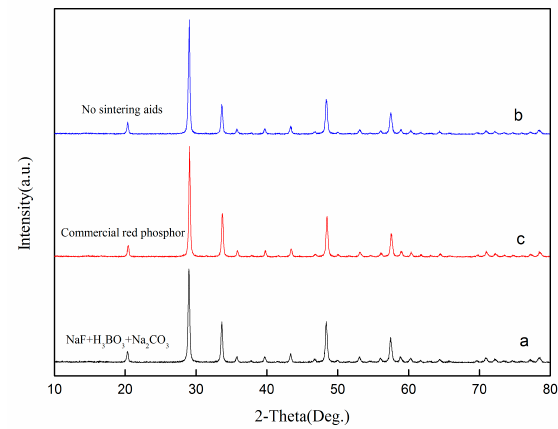
Figure 12. XRD pattern of Y 2 O 3 :Eu 3+ annealed at 1400 ° C with sintering aids ( a ); without sintering aids ( b ); and commercial red phosphor ( c ).